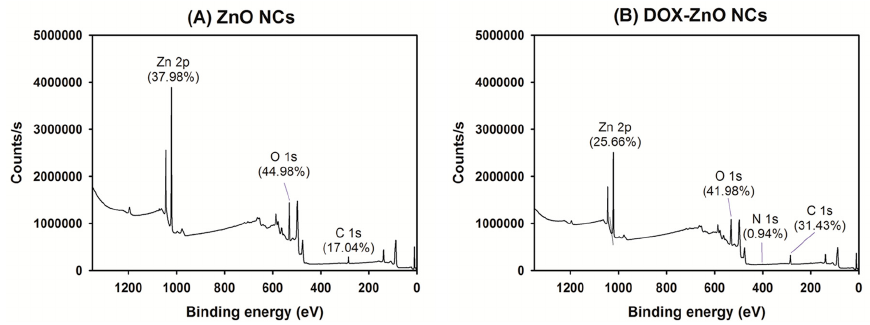
Figure 5. XPS results of ( A ) ZnO NCs and ( B ) DOX-ZnO NCs. Counts/s value according to binding energy of each sample is plotted.